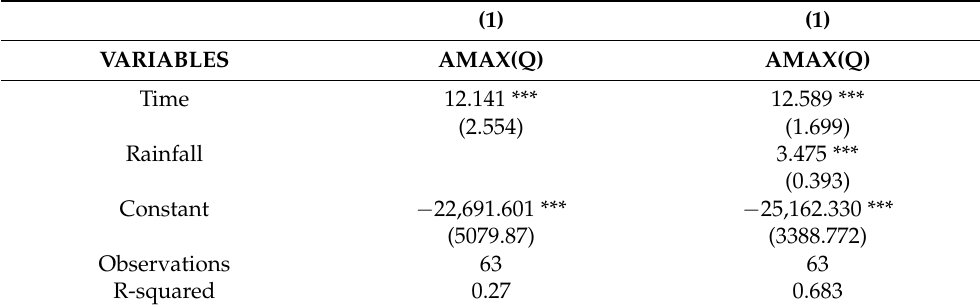
Table A2. Results of the regression of AMAX (Q) with time and rainfall over the Niger river Basin at